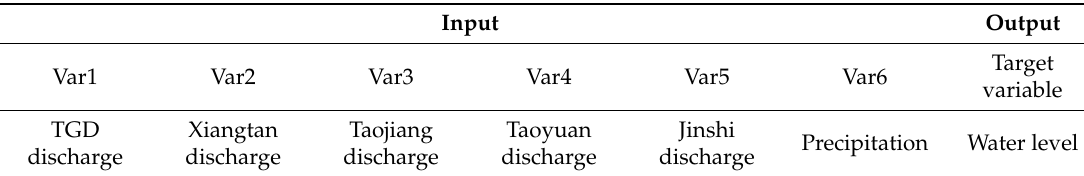
Table 5. Input and output variables for the SVM model.